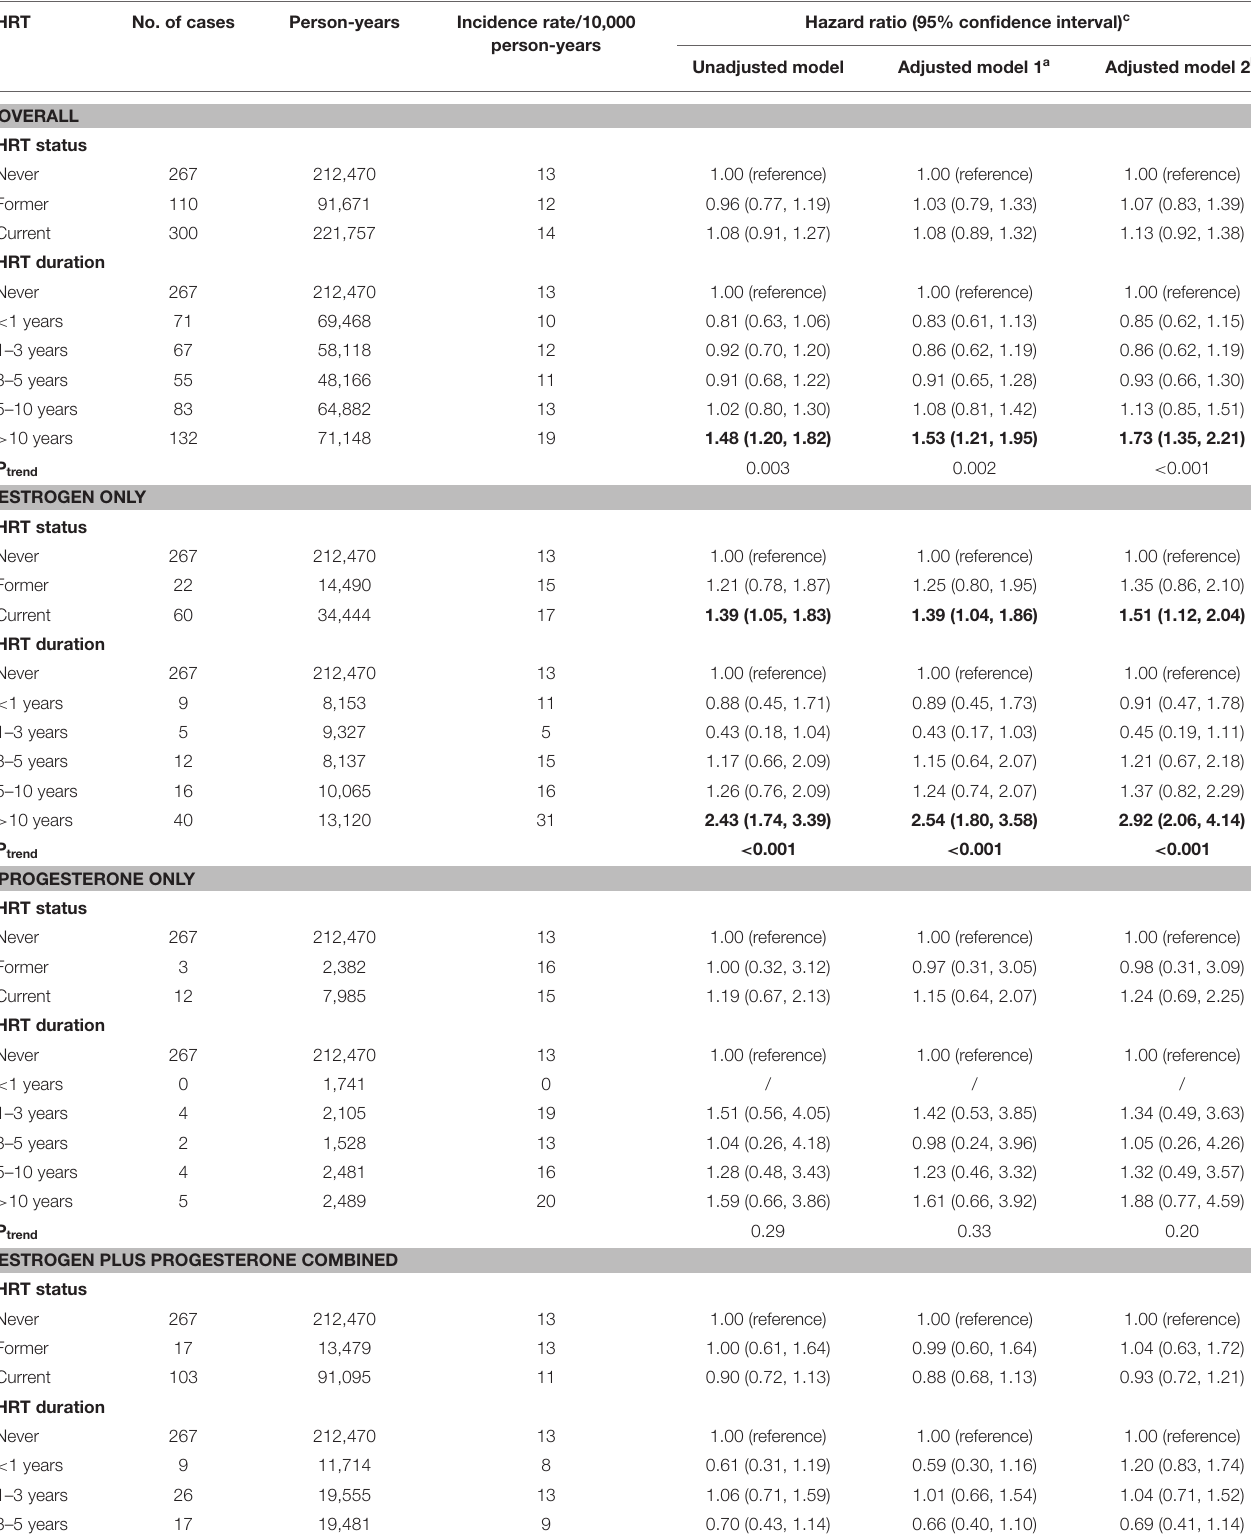
TABLE 2 | HRs (95% CIs) for endometrial cancer incidence and death by hormone replacement therapy status in the screening arm of the PLCO screening trial: 1993–2009.